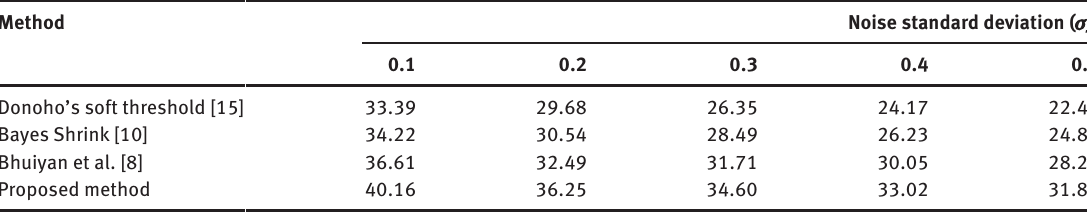
Figure 7: De-noising Performance on MR Image. (A) Ground truth. (B) Ground truth image corrupted with white Gaussian noise with σ soft threshold. (D) Image de-noising using Bayes Shrink. (E) Image de-noising using method in Ref. [8]. (F) Image de-noising using the proposed Table 1: Comparison of PSNR (dB) Performance for MR Images.